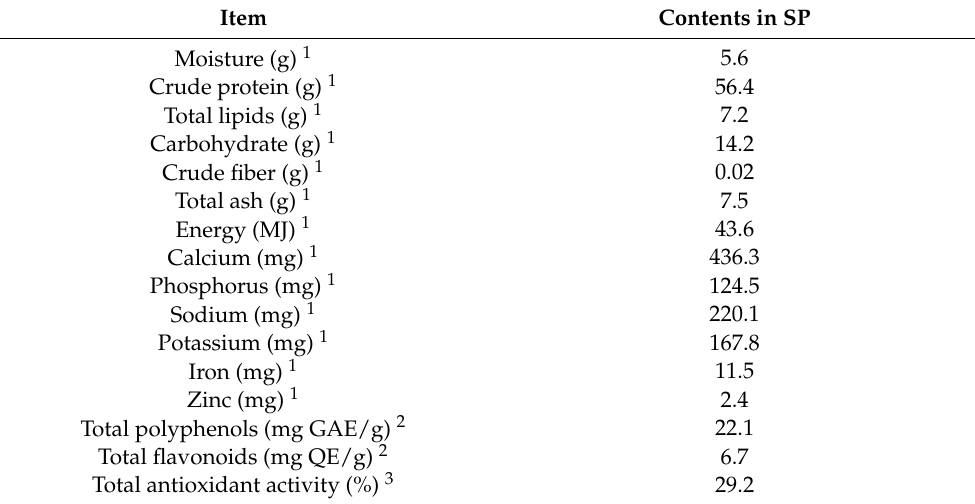
Table 1. The results of Spirulina platensisis (SP) chemical composition